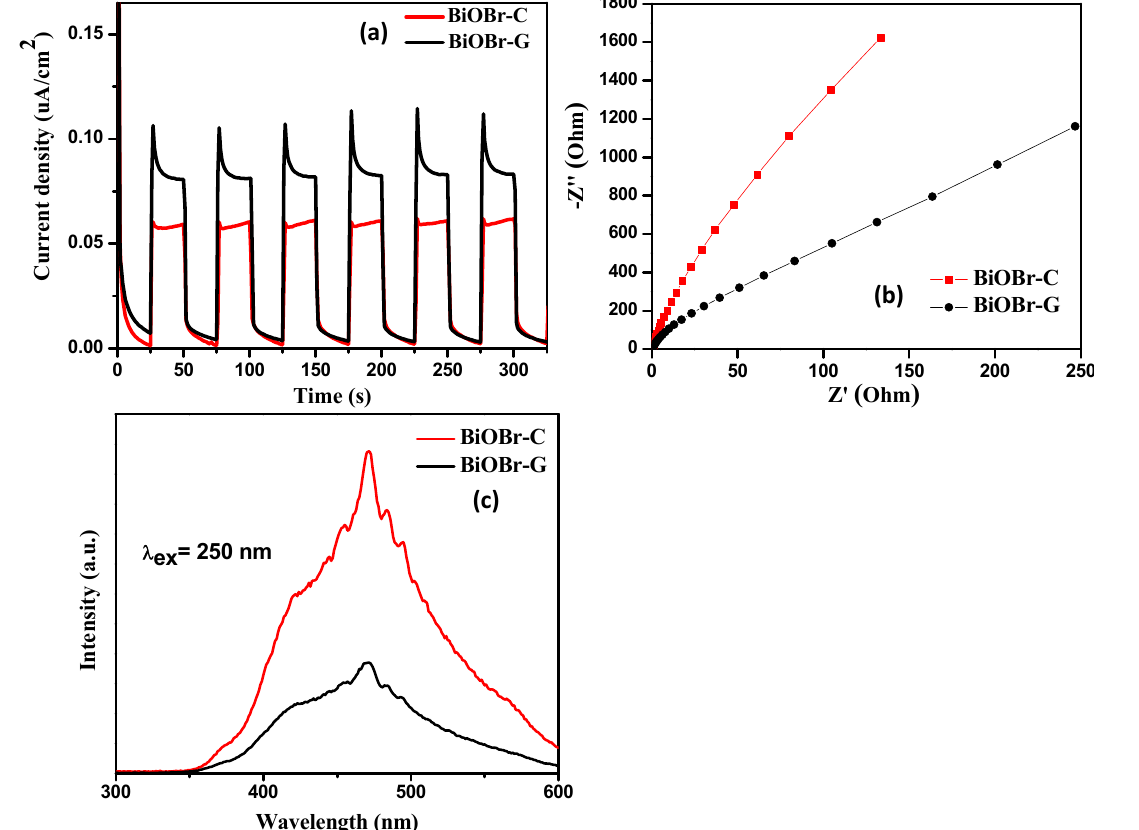
Figure 9. ( a ) Transient photocurrent response, ( b ) EIS Nyquist plots, and ( c ) PL spectra of BiOBr ‐ C and BiOBr ‐ G.